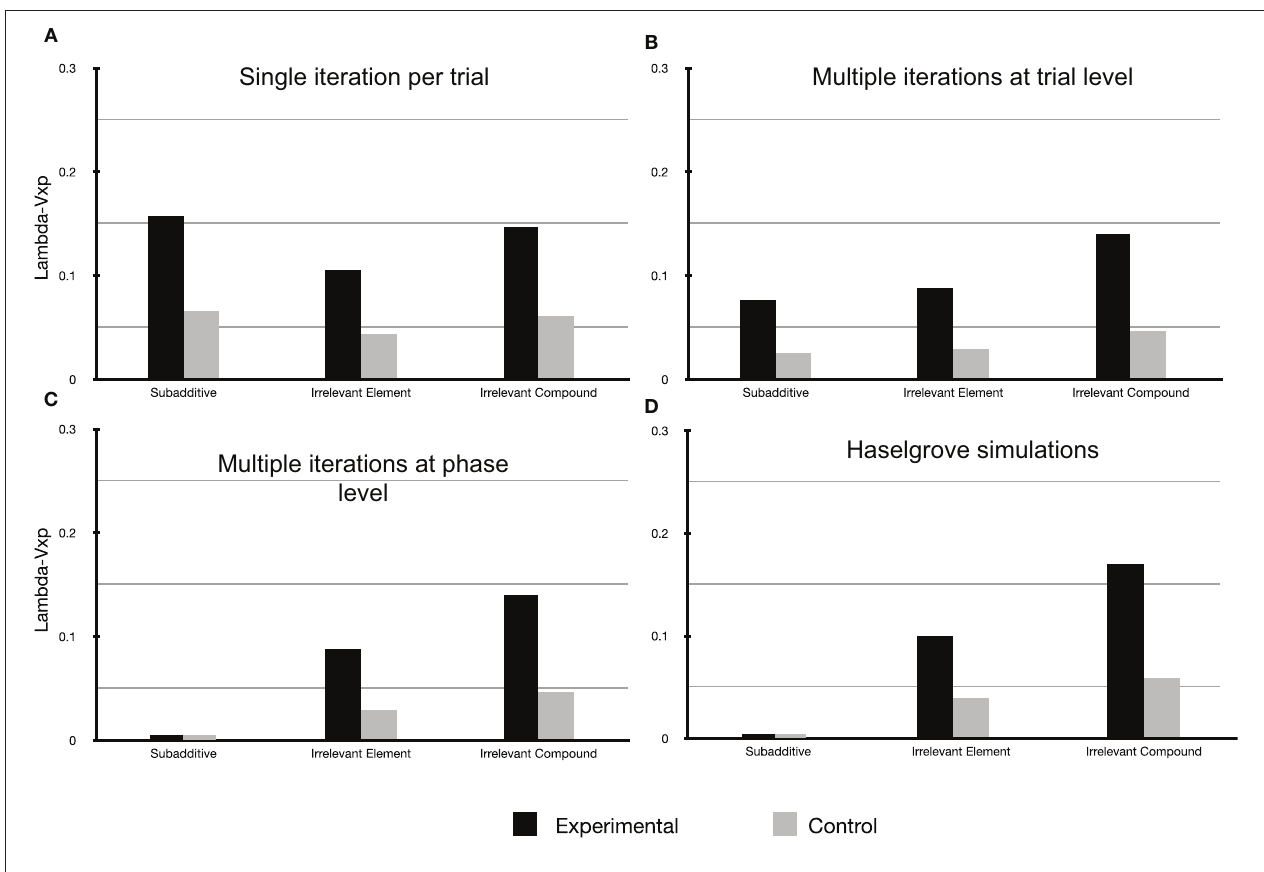
the model per discrete trial). (C) Simulation of the Rescorla-Wagner model FiGurE 2 | For all simulations presented here a = 0.2, where i stands i assuming a common element p and that each learning phase reached its for any of the cues used (i.e., the learning rate for each cue is identical) asymptote (by multiple iterations of the model at the learning phase level). and b = l = 0.7 as per Haselgrove (2010). (A) Straight forward simulation (D) Simulation redrawn from Haselgrove (2010). Please note that in the case of the Rescorla-Wagner model assuming a common element p. (B) of (C,D) , and for the subadditive group, the value of Lambda − V Simulation of the Rescorla-Wagner model assuming a common element p and that each learning phase reached its asymptote (by multiple iterations of equal